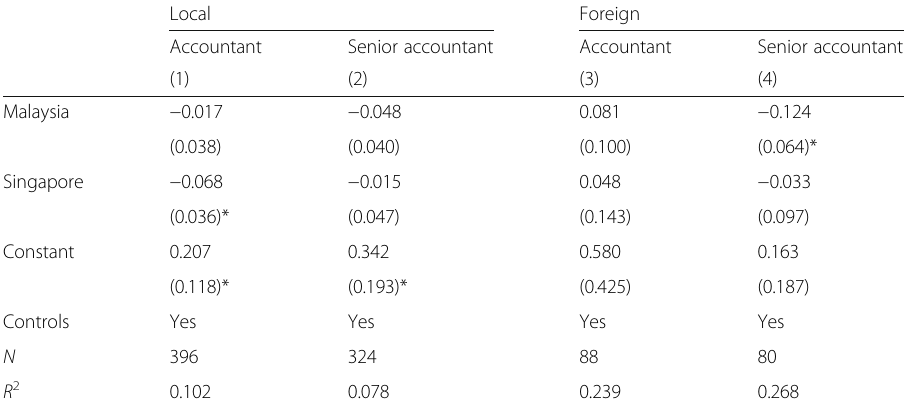
Table 11 Dependent variable: if a resume receives a callback for an interview